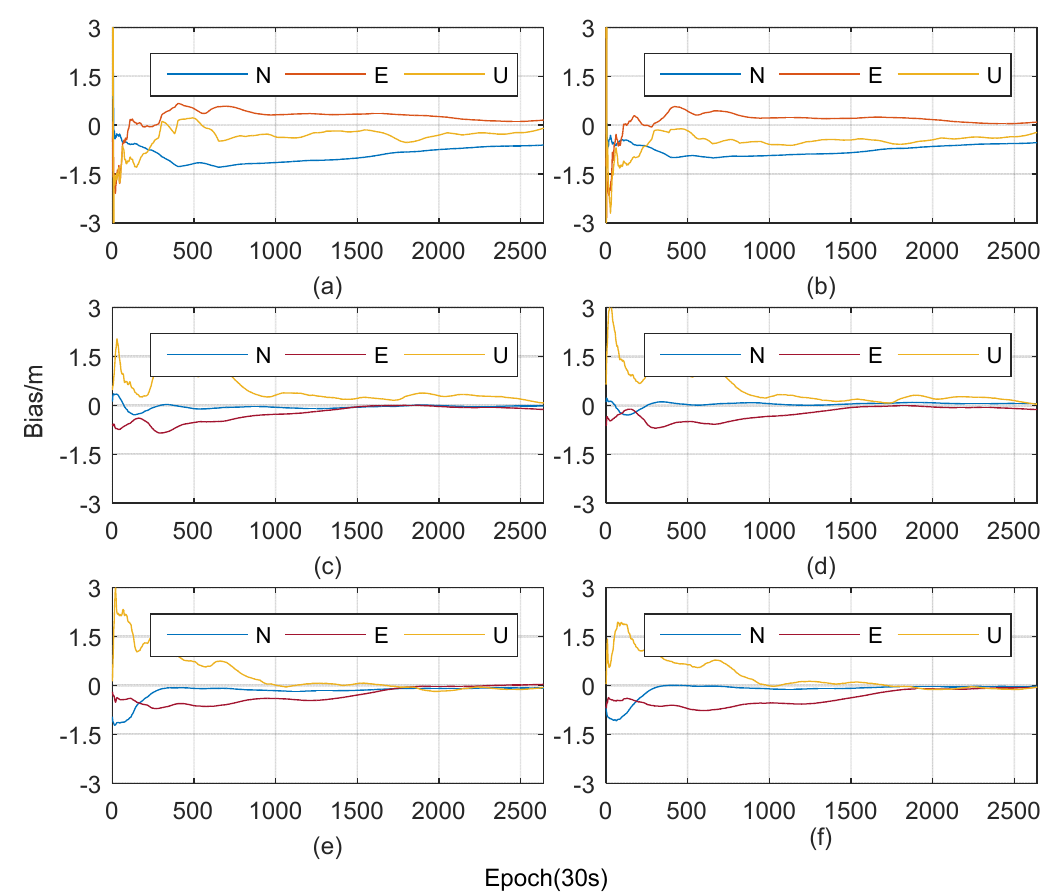
Figure 9. Single-frequency PPP results. ( a , c , e ) Station BTRD with no ionosphere model, the POLY and the SVM-P. ( b , d , f ) Station GTBH with no ionosphere model, the polynomial (POLY) and the Support Vector Machine (SVM-P.)